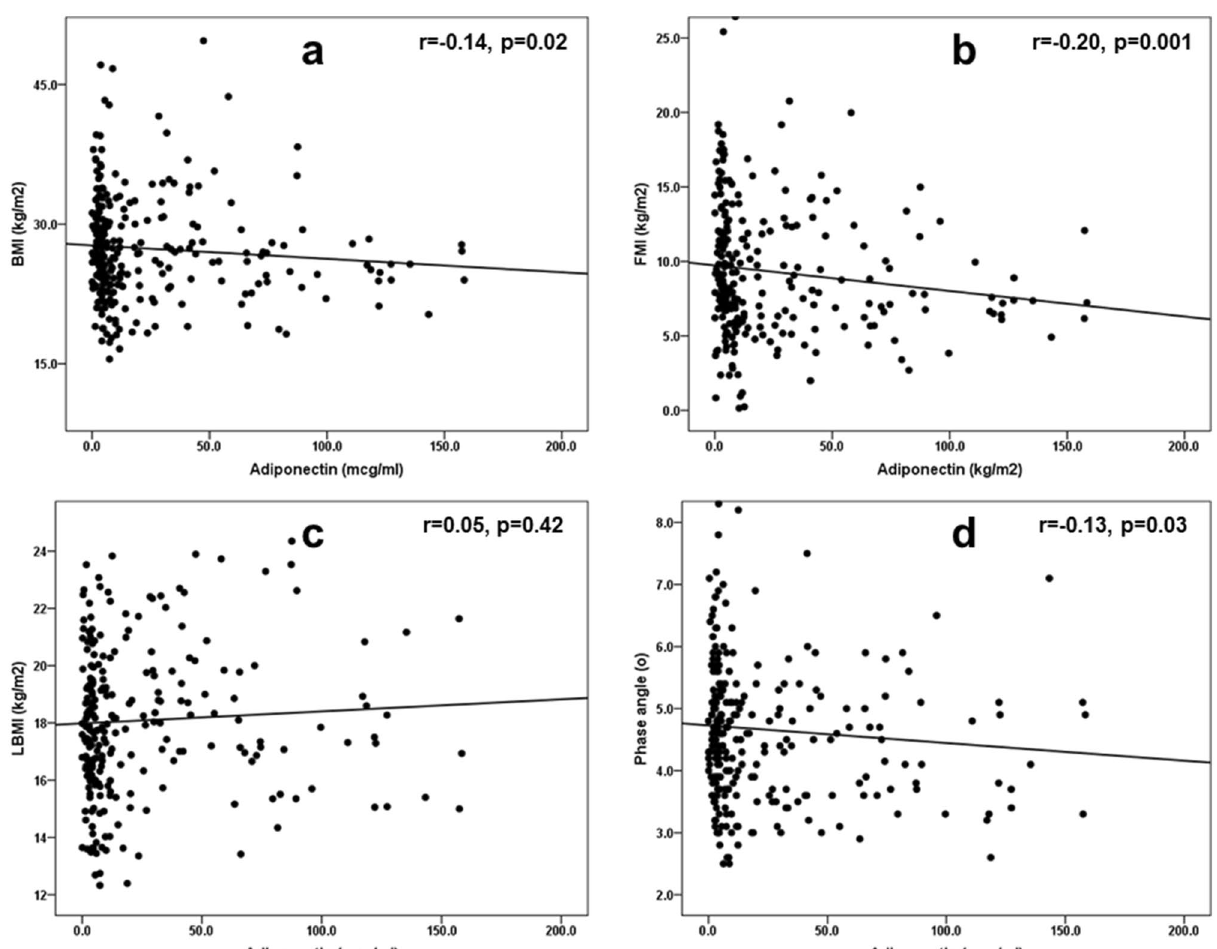
Figure 1. Spearman’s correlations between serum adiponectin (mcg/ml) and the body composition parameters [( a ) BMI, ( b ) FMI, ( c ) LBMI, ( d ) phase angle] in the study population (n = 261). Abbreviations: BMI, body mass index; FMI, fat mass index; LBMI, lean body mass